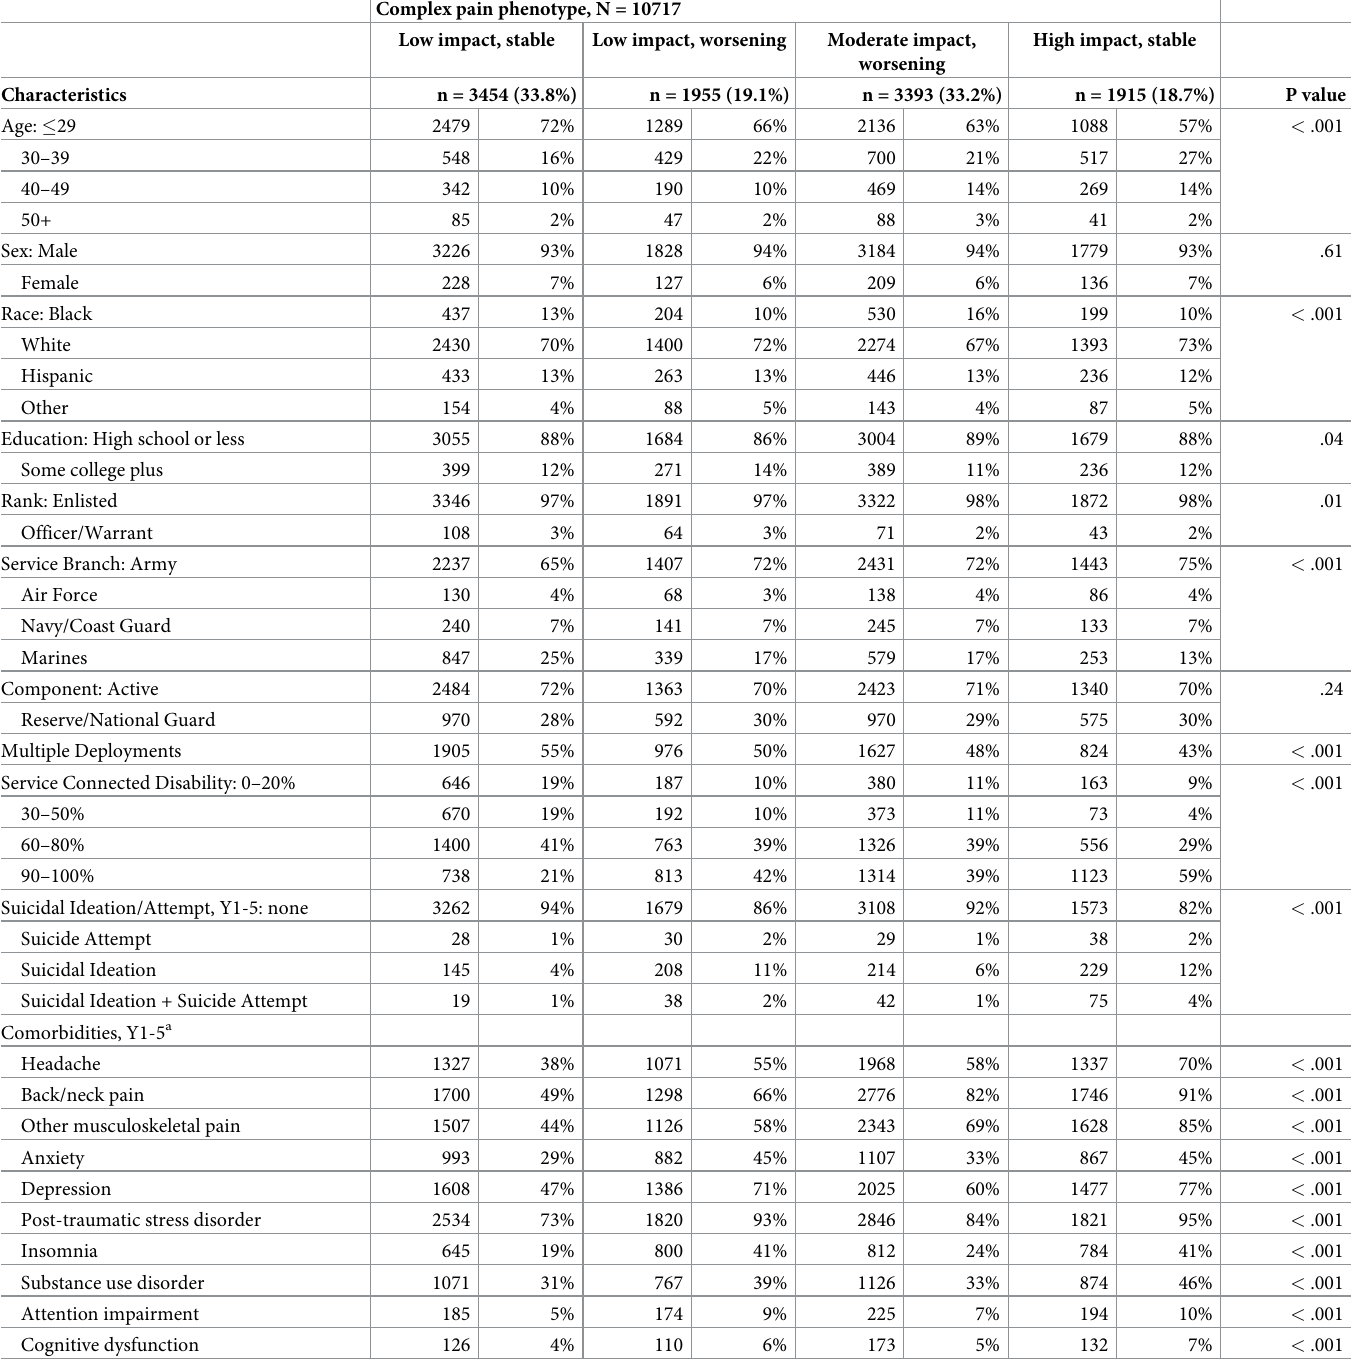
Table 1. Demographic and clinical characteristics by complex pain